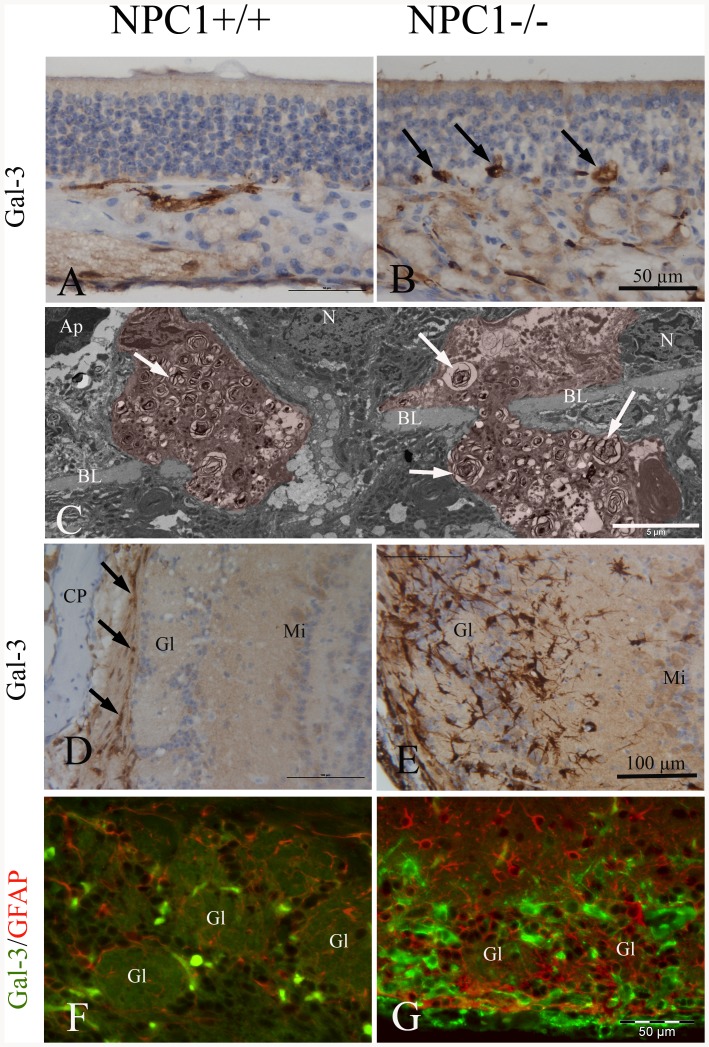
Immunohistochemistry of Gal-3 in the OE (A, B) and OB (D, E) (67–70 d).(A) Gal-3 in NPC1+/+ is restricted to olfactory axon bundles in the lamina propria, whereas in NPC1−/− animals (B), large spot-like Gal-3 reaction product is detectable above and below the basal membrane. Note tender processes of these cells, presumably macrophages (arrows). These cells correspond most likely to those depicted in C. (C) Interface between olfactory mucosa and lamina propria. Electron microscopic resolution of two macrophages (red) filled with myelin-like material (arrows). These cells penetrate the basal lamina (BL). N- nuclei of horizontal basal cells; Ap- nucleus of an apoptotic cell. (D) NPC1+/+, cortical layers of the olfactory bulb express Gal-3 immunoreactivity only in nuclei of ensheathing cells within the nerve fiber layer (arrows). Deeper bulb areas, i.e., as glomerular (Gl), mitral cell (Mi), and granular (Gr) layers, are not affected. (E) Numerous Gal-3-positive cells occupy the glomerular and adjacent part of the external plexiform layer in an NPC1−/− animal. These cells have partly short and interrupted processes different from those of astroglia. Glomeruli are barely recognizable. (F, G) Double immunofluorescence, using antibodies against GFAP (red) and Gal-3 (green). (F) GFAP reactive astrocytes are mainly distributed within the glomerular layer. There are only a few Gal-3-positive microglia cells in NPC1+/+ animals. (G) Prominent microgliosis (Gal-3 expression) especially around glomeruli goes along with enhanced reactivity for GFAP, indicating which indicates astrogliosis. Macrophage activity is most likely associated with microglia rather than with activated astrocytes. Astrocytes do not co-express Gal-3.